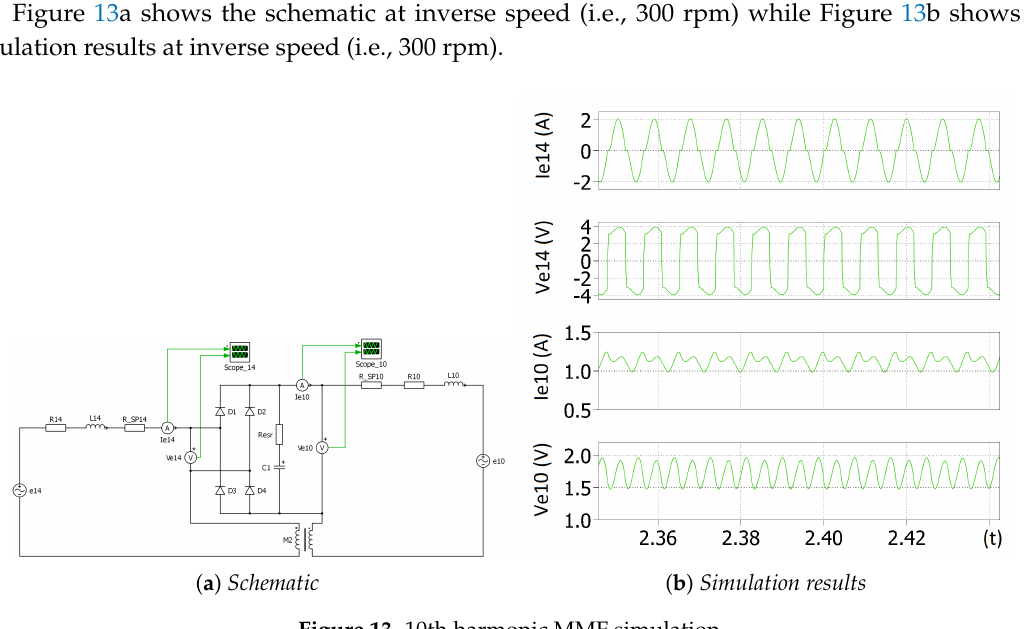
Figure 13. 10th harmonic MMF simulation.